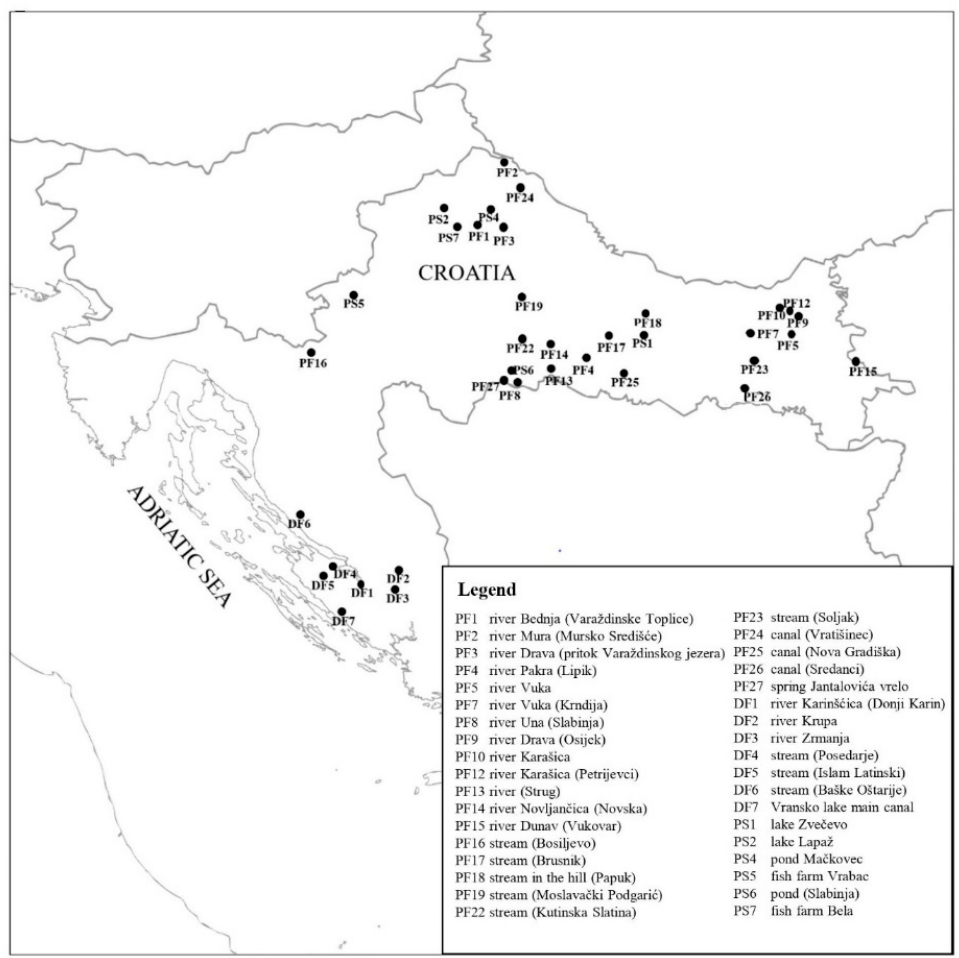
Figure 1. Locations of water sampling ( n = 36) in Croatia. P—Pannonian ecoregion, D—Dinaric ecoregion, F—flowing, S—stagnant.